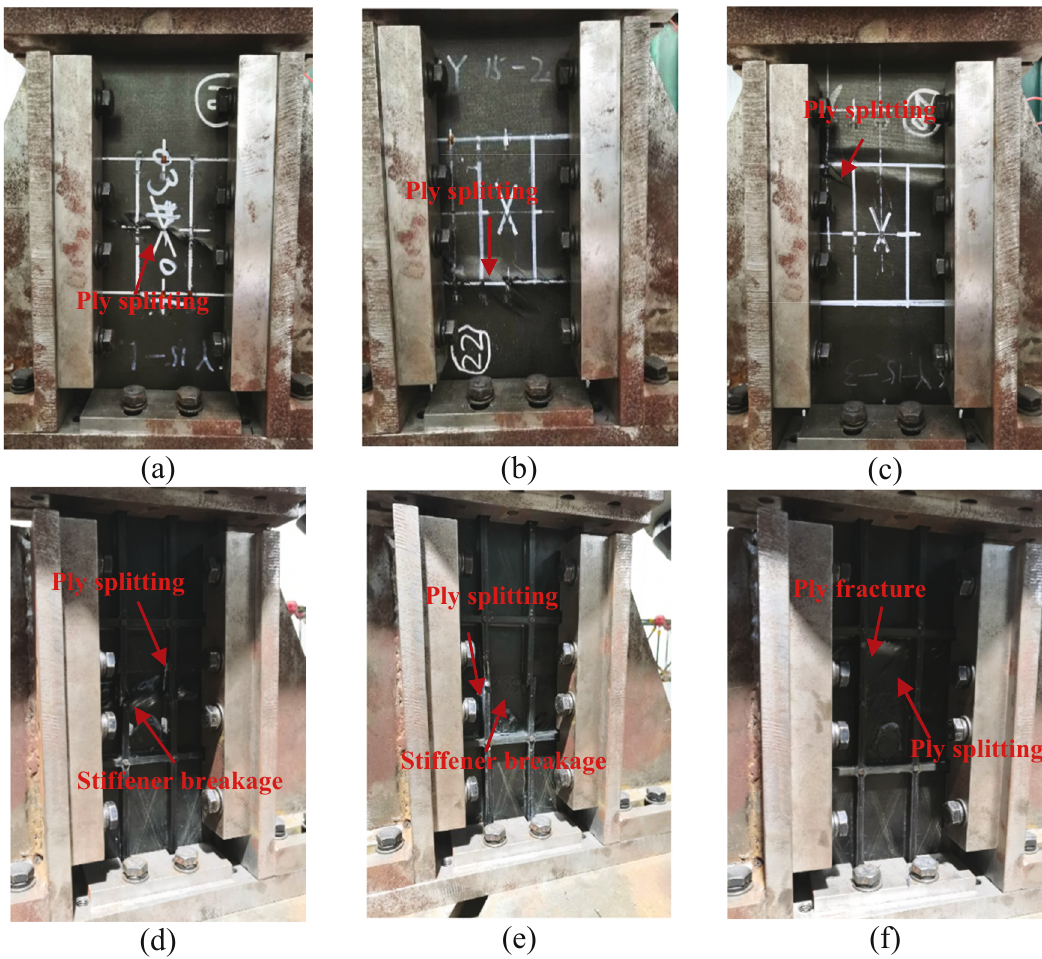
Figure 11: Compression damage of the specimen after aging for 45 days: ( a and d ) #6; ( b and e ) #7; and ( c and f )